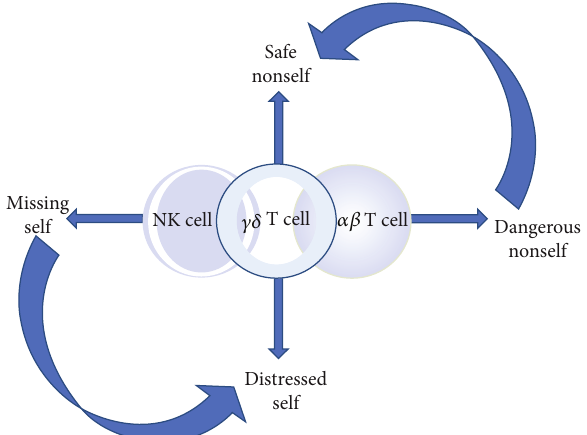
Figure1:Asimplifiedparadigmillustratingwhereinthecontinuum of immune protection and homeostasis 𝛾𝛿 T cells fall in relation to innate NK cells and the adaptive 𝛼𝛽 T cells. Innate NK and adaptive 𝛼𝛽 T cells respond to the “missing self” and the “dangerous nonself,” respectively, while, between these two extremes, 𝛾𝛿 T cells respond to the “safe nonself” and deal with the inevitable “distressed self.” Thesedifferent“selves”andtheimmuneresponse(s)thattheytrigger exist in a continuum and are modulated by the context in which they are presented. Besides, NK cells could contribute to responding to the “distressed self,” whereas 𝛼𝛽 T cells have some regulatory training to temper the response to the “safe nonself” (cited from